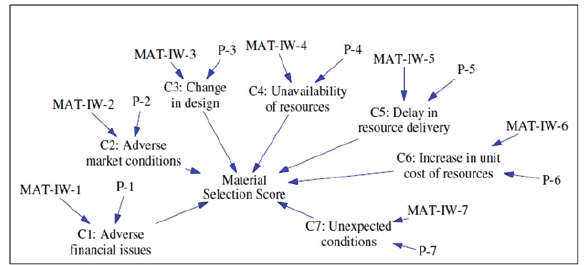
Fig. 3. Relations between project conditions and material selection